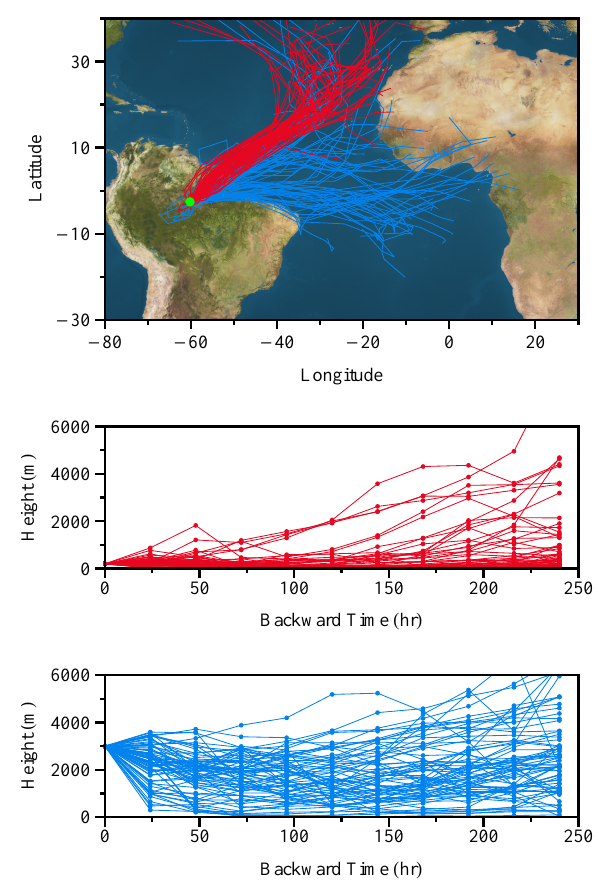
Fig. 4. Ten-day HYSPLIT backtrajectories at 200 m (red) and 3000 m (blue) during AMAZE-08. Each point along a trajectory represents a 12-h step. The green point marks the location of tower TT34.